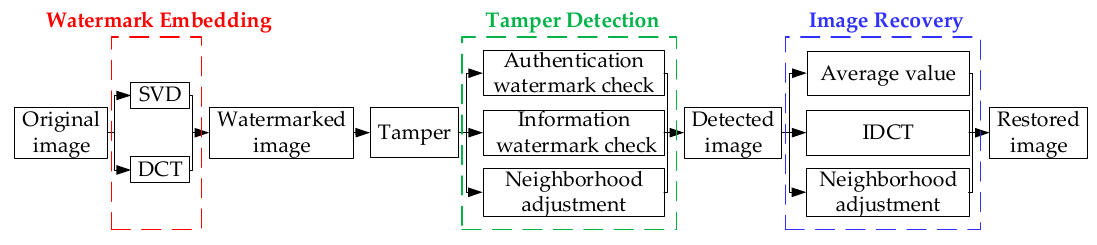
Figure 1. A brief overview of the method in Reference [7].